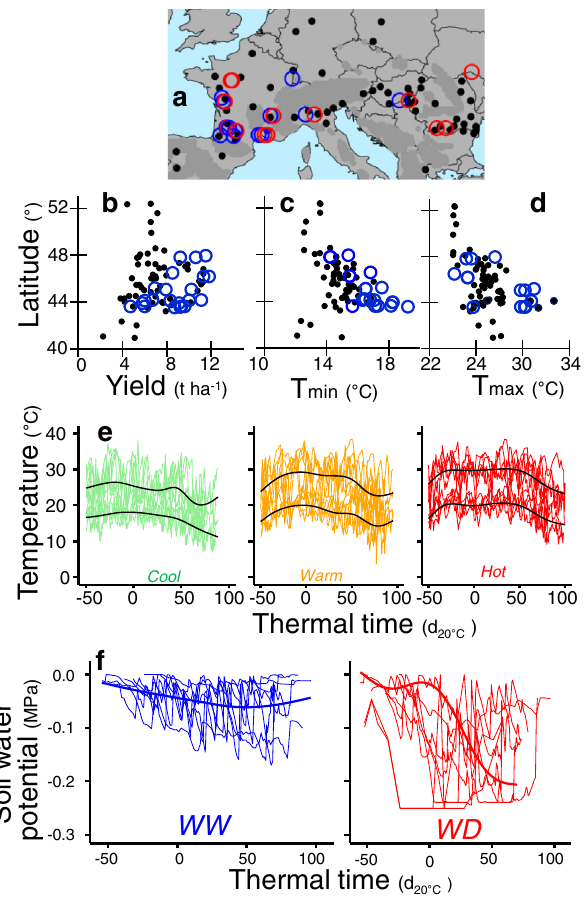
Fig. 1 The fi eld experiments covered the latitudes with maximum area of maize in Europe, and represented a large part of the variability of yield and environmental conditions. a Map of fi eld experiments, blue and red circles for well-watered and water de fi cit experiments, and of 59 sites distributed over Europe for representation of the maize growing area. b – d Yield, minimum and maximum temperatures in experiments as a function of latitude, compared with means for 59 sites over 35 years. e Three temperature scenarios captured a large part of the variability of temperature in the fi eld experiments. Time courses of air temperature in the scenarios cool, warm, and hot. Each line represents one fi eld, black lines, mean time course. f Time courses of soil water potential for fi elds classi fi ed as belonging to well-watered or water de fi cit scenarios. Each line represents one fi eld. In e and f , time is centred on fl owering time, in equivalent days at 20 °C (d 20°C ). Experiments i, j, l and m, see supplementary Table 2. Source data in Supplementary data 1.